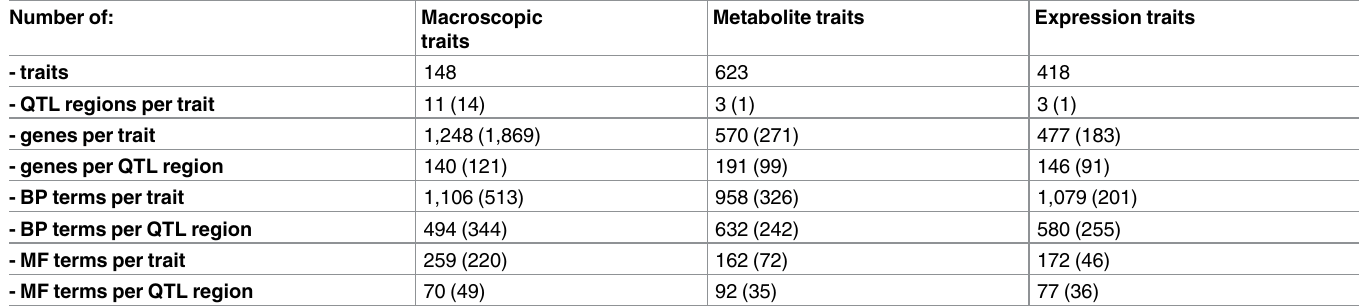
Table 1. Descriptivestatistics of datasets used a